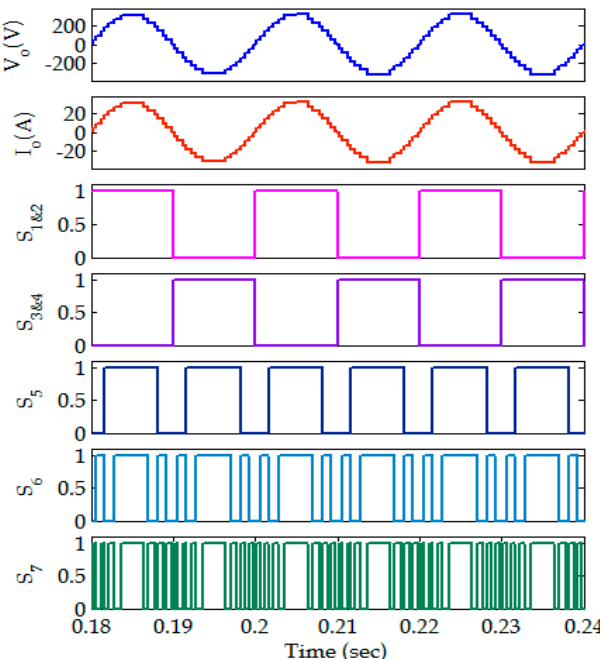
Figure 4. Output waveforms and switching pattern of reduced switch 15 − level MLI.